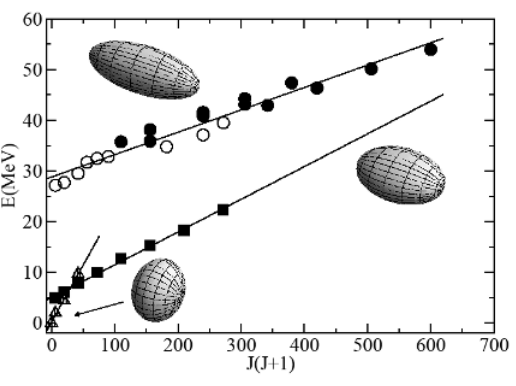
Fig. 2. The shape isomers of the 36 Ar nucleus from Nilsson- model calculations, and their amalgamation from two clusters. The central part shows the shell-model results for the ground (at the bottom), superdeformed, triaxial, and hyperdeformed (at the top) states. The left column corresponds to the 24 Mg + 12 C clusterization. The right side illustrates the 32 S + 4 He, 20 Ne + 16 O, 28 Si(prolate) + 8 Be, 28 Si(prolate) + 8 Be, 20 Ne + 16 O configurations (from the bottom), respectively. At the upper most line also the alpha-clusterization of the HD state is shown from the work [44], where the contour corresponds to the HD state of the Nilsson-